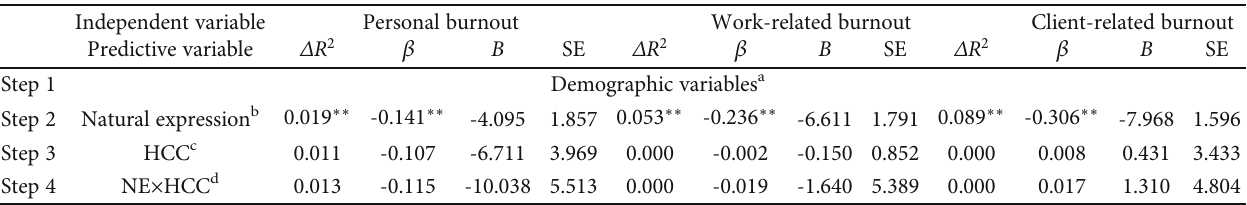
Table 7: Coe ffi cients of multiple linear regression of expression of naturally felt emotions, hair cortisol content, and their interaction against Copenhagen job burnout ( n = 229